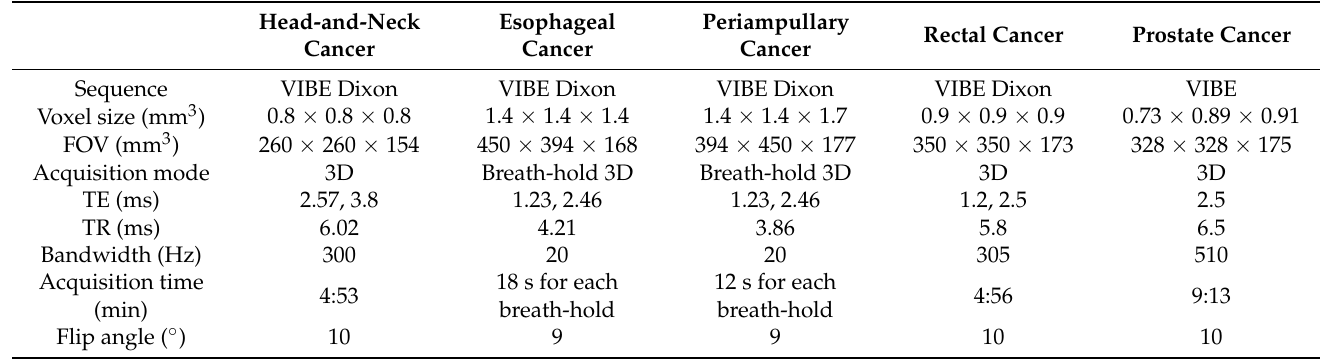
Table 2. Overview of parameters regarding the in vivo T1-weighted MR sequences.